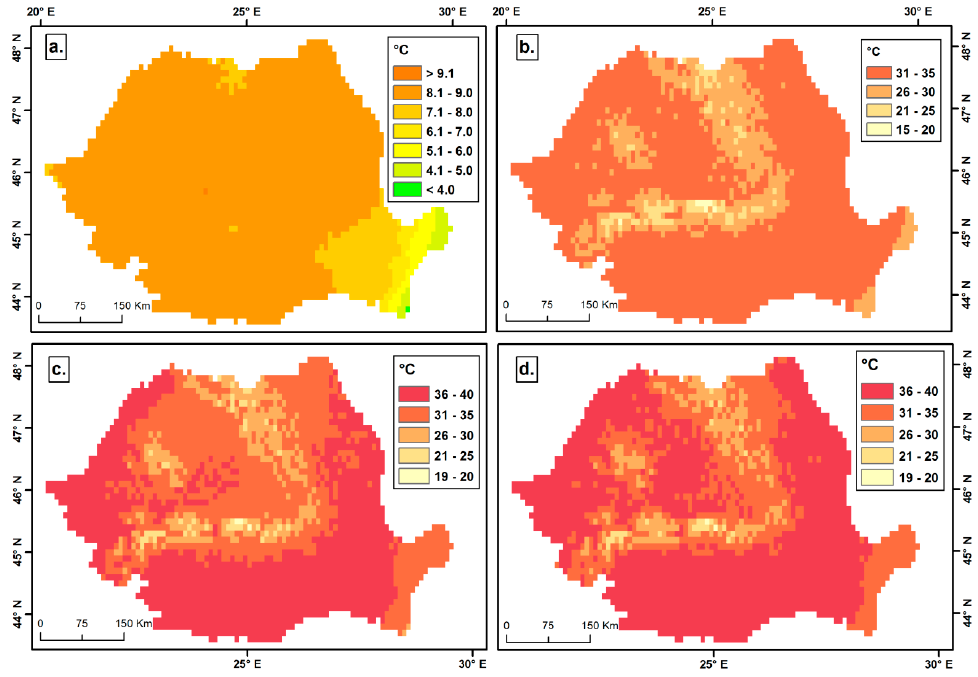
Figure 10. Mean maximum temperature anomaly in Romania in summer ( a ); and mean maximum temperature in: June ( b ); July ( c ); and August ( d ) for A2 HW type based on ROCADA gridded database.